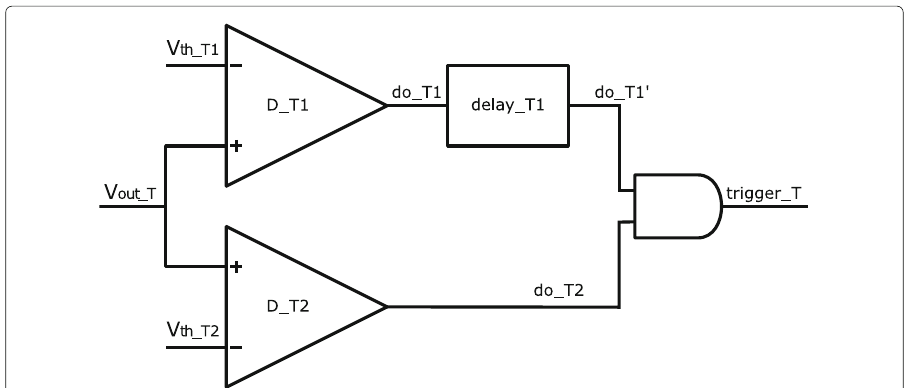
Fig. 1 Schematic drawing of the TOFPET2 channel trigger circuit. In the timing branch of the trigger circuit, the output of the first discriminator D_T1 is delay by a configurable delay element with respect to the output of the second discriminator D_T2. The design allows the rejection of small noise